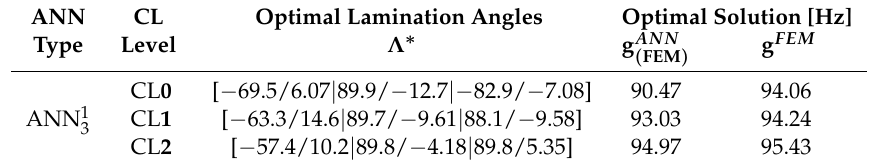
Figure 8. Optimization of f 1 using MODEL2 with four symmetric layers of laminate. Table 11. Numerical results of f 1 optimization using MODEL2 with four symmetric layers of